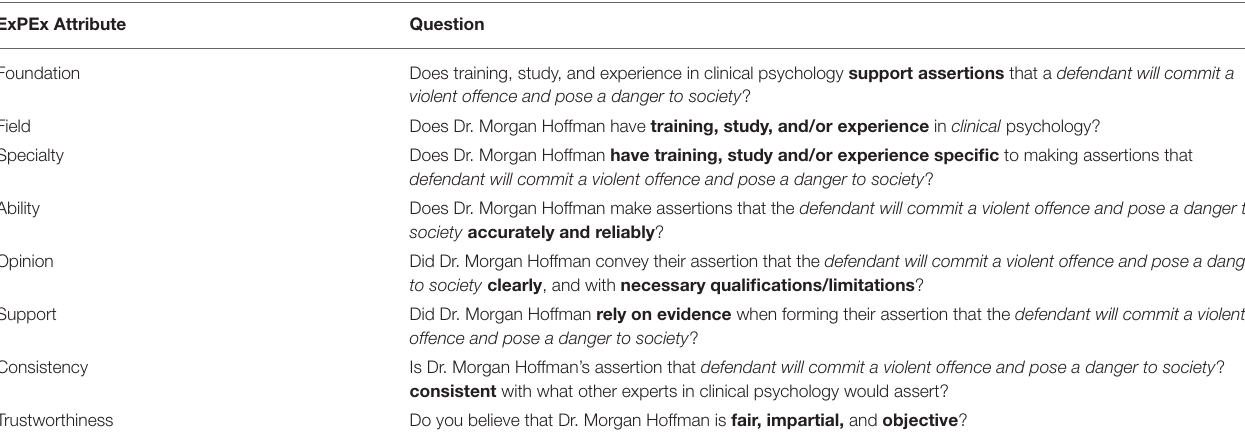
TABLE 1 | Expert persuasion expectancy (ExPEx) quality items.